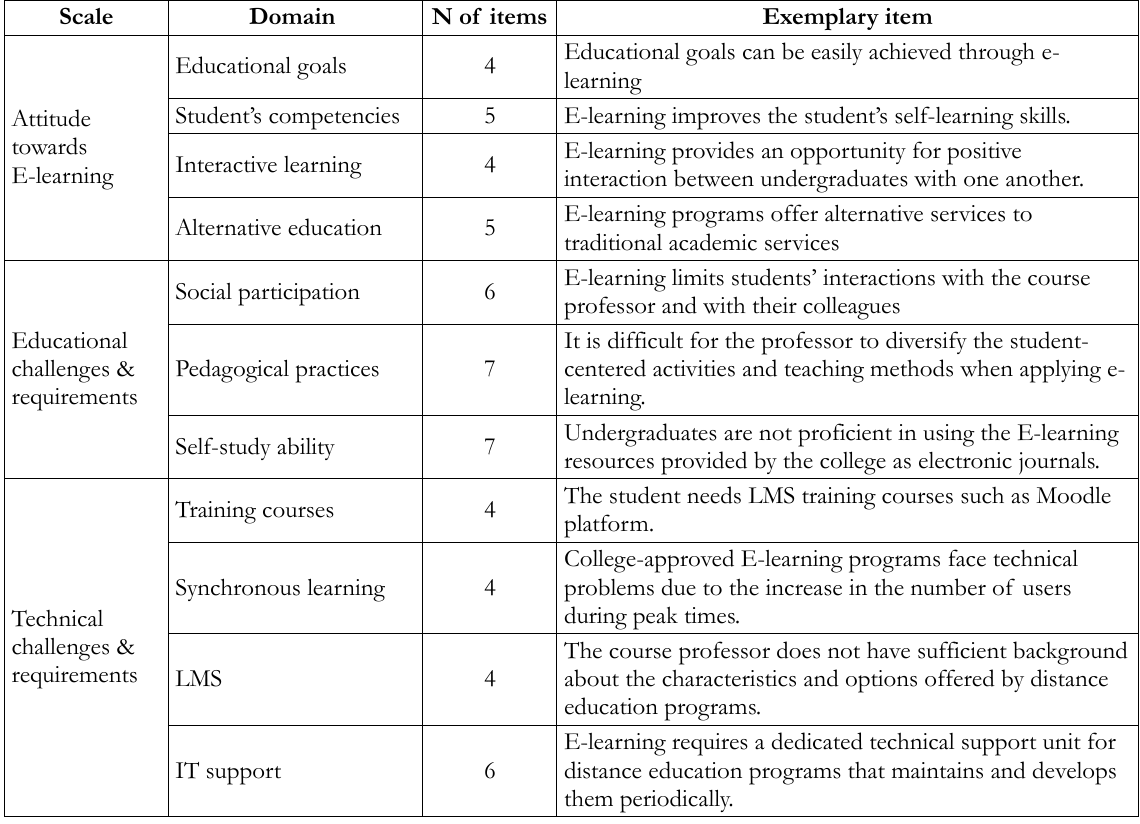
Table 4. Exemplary items from questionnaire’s